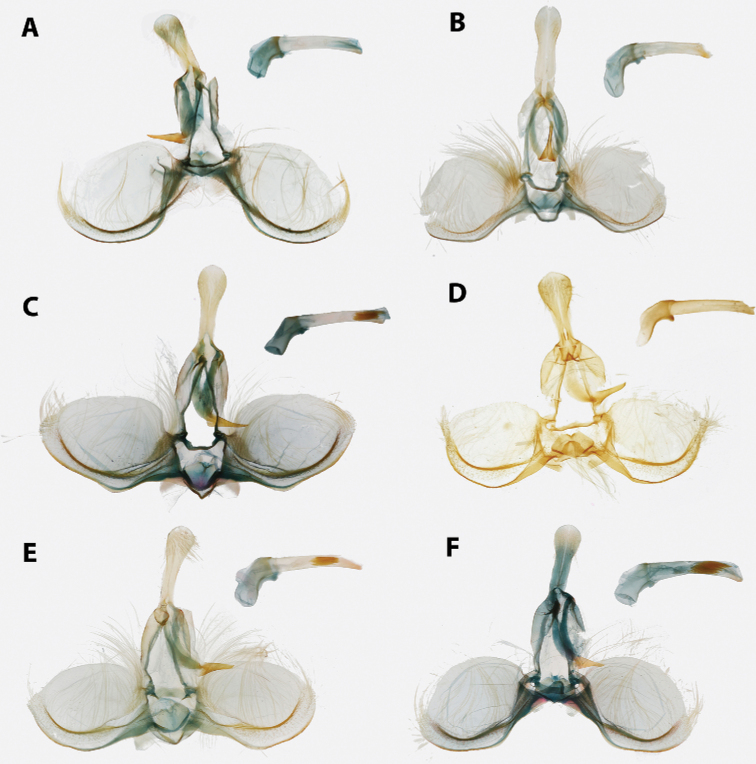
Argyrotaenia male genitalia. Not to scale. AA.
bisignata paratype, Dominican Republic. KAA diss. #0044 (CMNH) BA.
jamaicana, Jamaica. KAA diss. #0131 (USNM) CA.
razowskiana sp. nov. paratype, Dominican Republic. KAA diss. #0104 (CUIC) DA.
cryptica
praeteritana ssp. nov. holotype, Dominican Republic. Razowski diss. #10732 (CMNH) EA.
cryptica
cryptica ssp. nov. paratype, Dominican Republic. KAA diss. #0115 (CMNH) FA.
paradisei sp. nov. paratype, Dominican Republic. KAA diss. #0116 (CMNH).